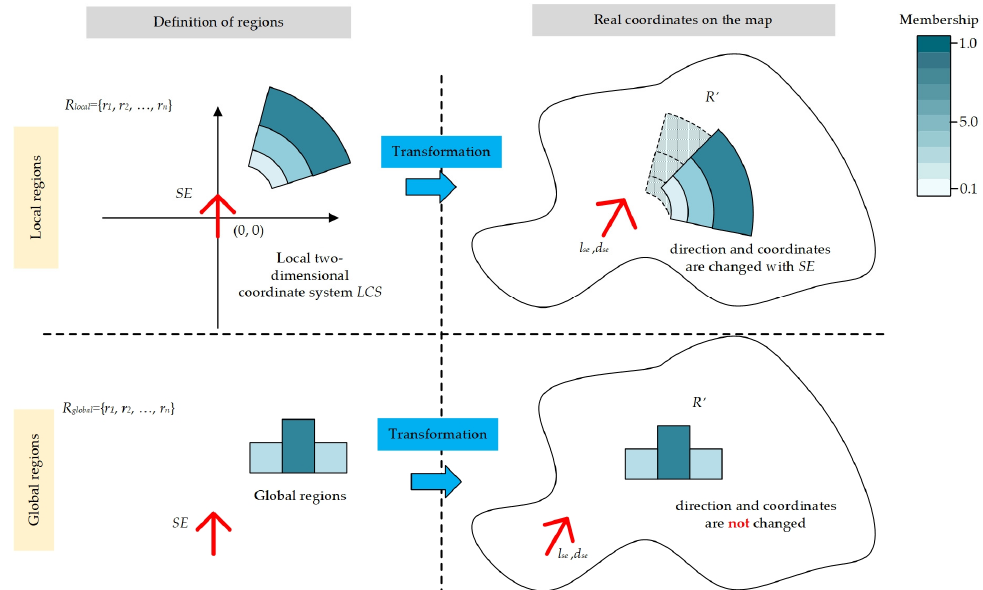
Figure 1. The definition and coordinate transformation of local regions R local and global regions R global .